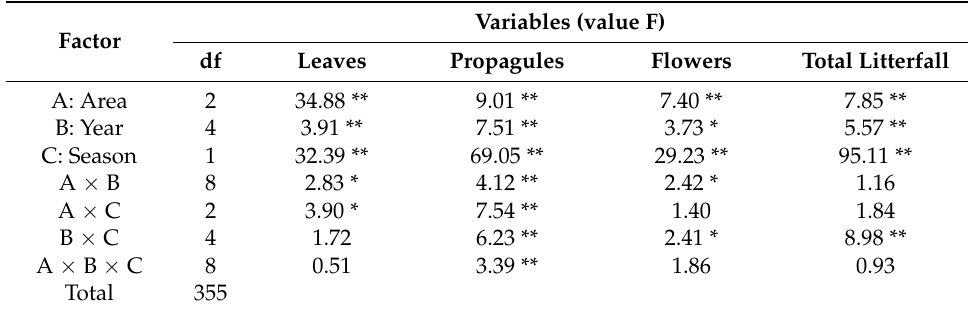
Table 6. Factorial ANOVA (three-factor) per area ( A ), year ( B ), and season ( C ), concerning the production of the litterfall component of Rhizophora mangle along the coast of Campeche. Variables (value F) Factor df Leaves Propagules Flowers Total Litterfall A: Area